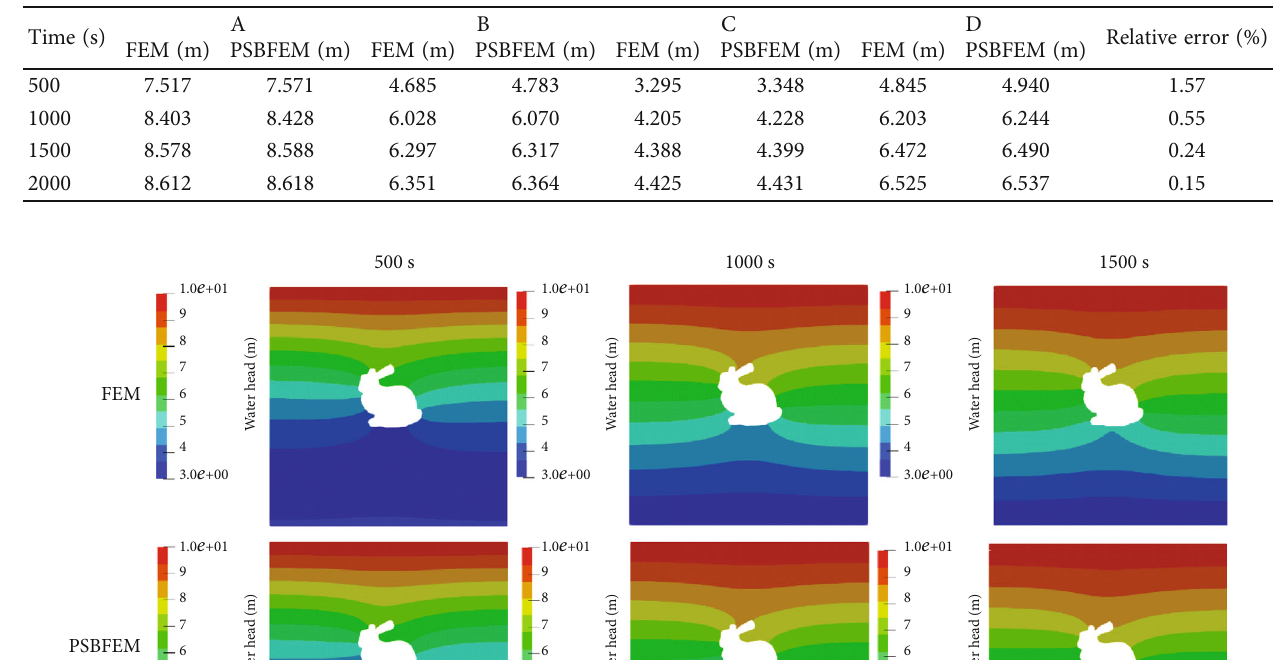
Table 2: Water head of the monitor points at di ff erent times.